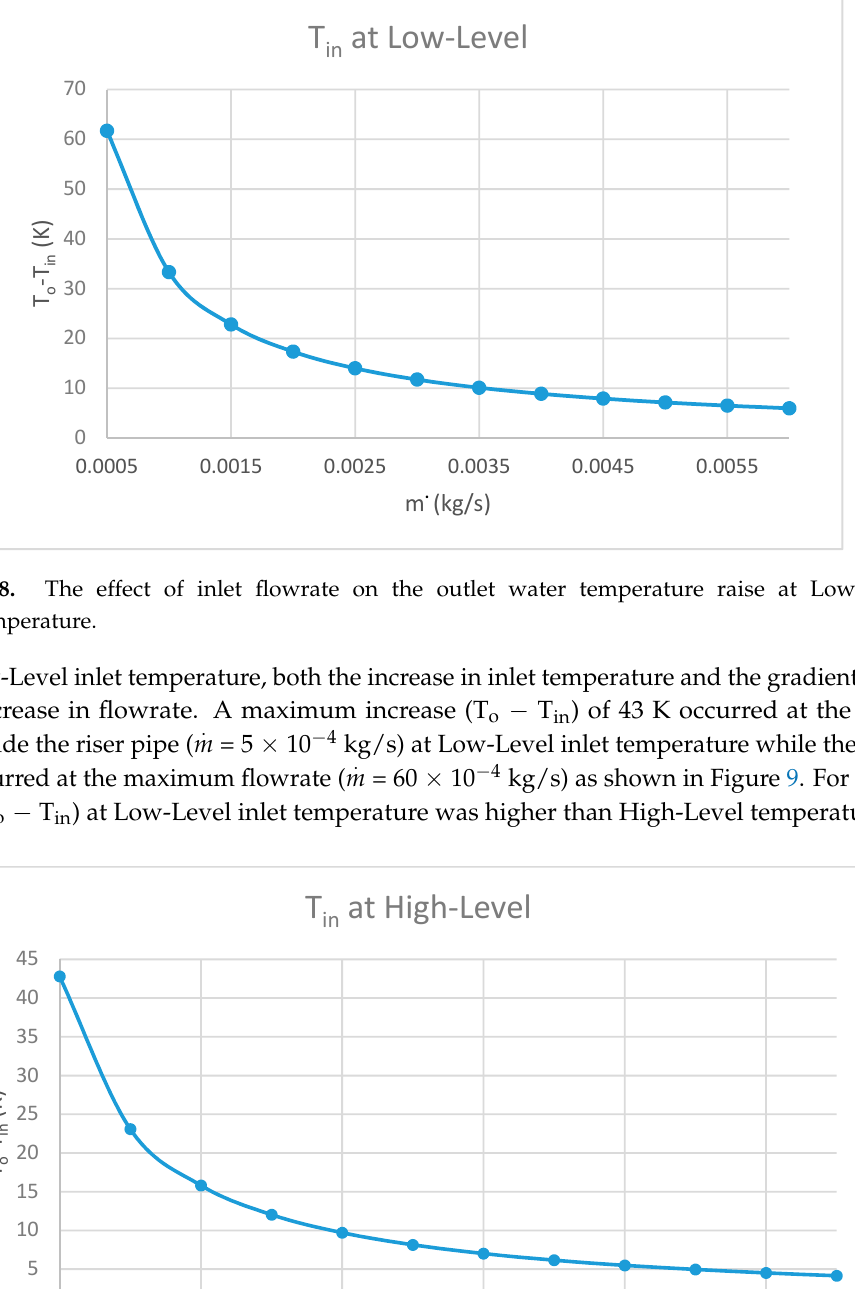
Figure 7. The impact of flow rate on the variation water temperature for different range of flow rate.